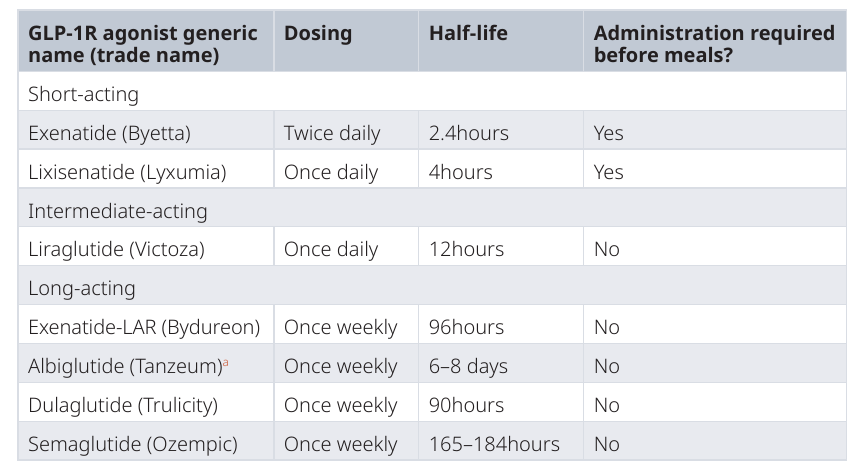
Table 1. Current glucagon-like peptide 1 receptor (GLP-1R) agonists used in type 2 diabetes